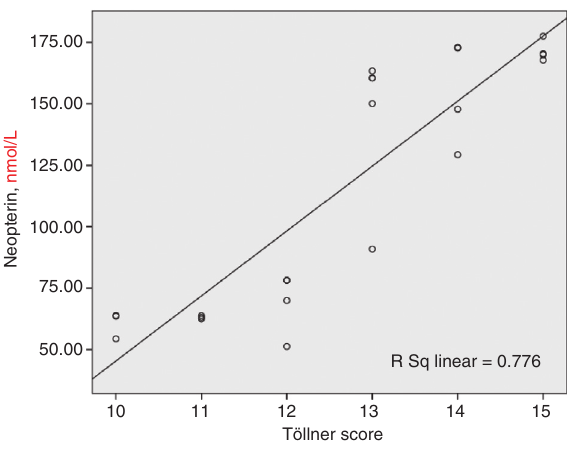
Figure 1 Correlation between neopterin levels and Töllner sepsis